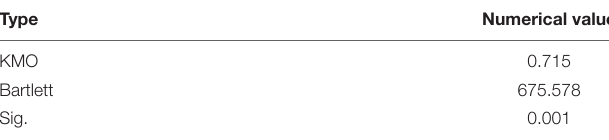
TABLE 3 | Analysis results of the validity of the